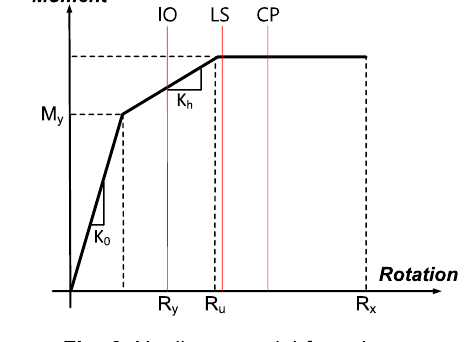
Fig. 6 Nonlinear model for columns.